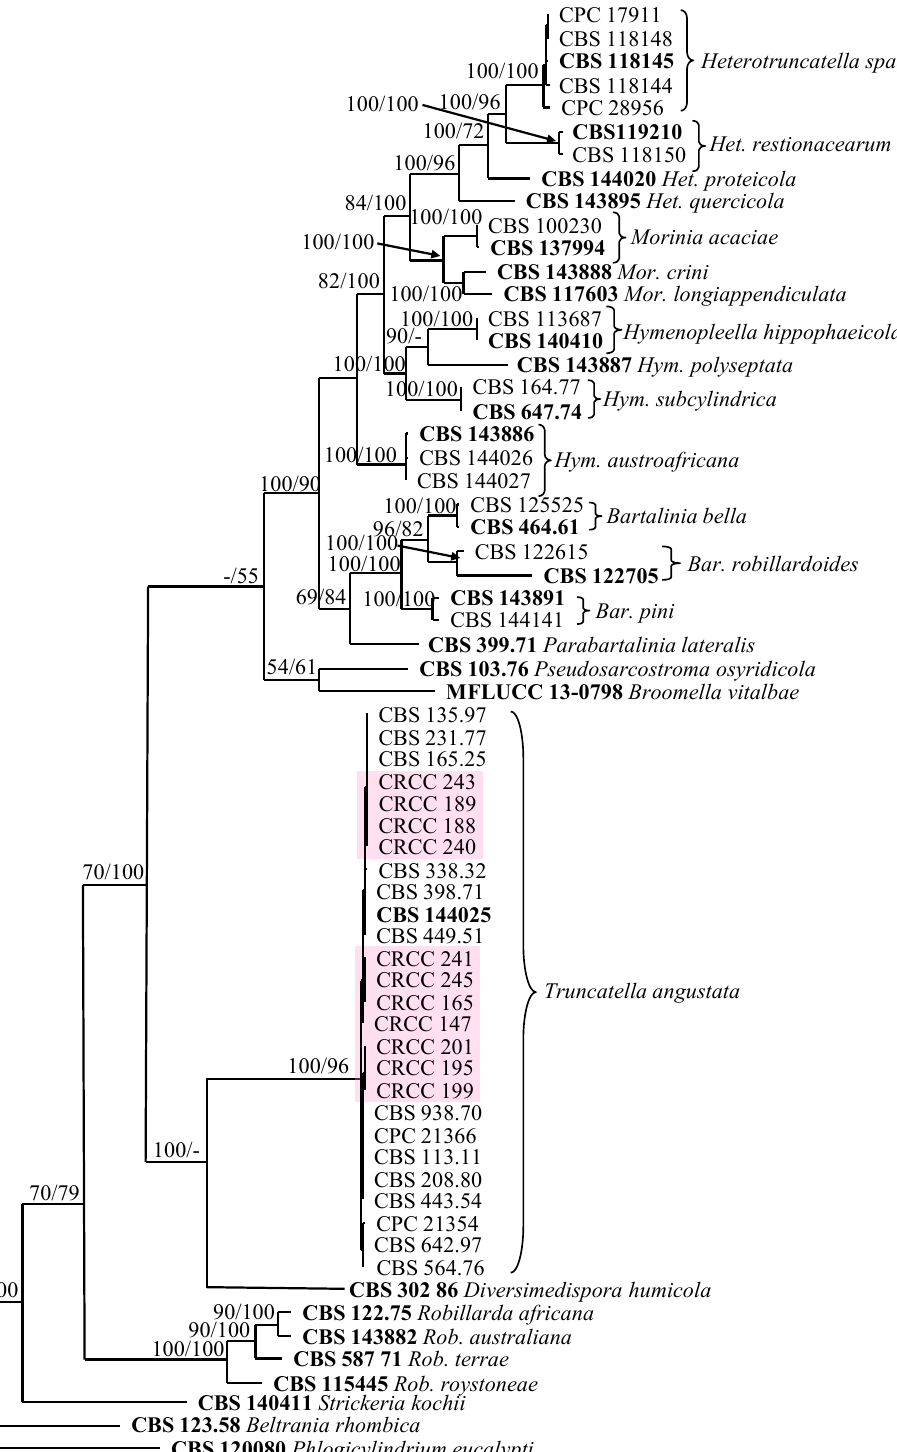
Figure 3. One of the most parsimonious trees obtained from combined alignment of the LSU, ITS, tub , tef-1 α and rpb2 sequence datasets of Truncatella isolates, with bootstrap support values from maximum parsimony/maximum likelihood analyses. Isolates obtained in this study are indicated by pink rectangles. Ex-type sequences are indicated in bold. Beltrania pseudorhombica and Phlogicylindrium eucalypti were used as